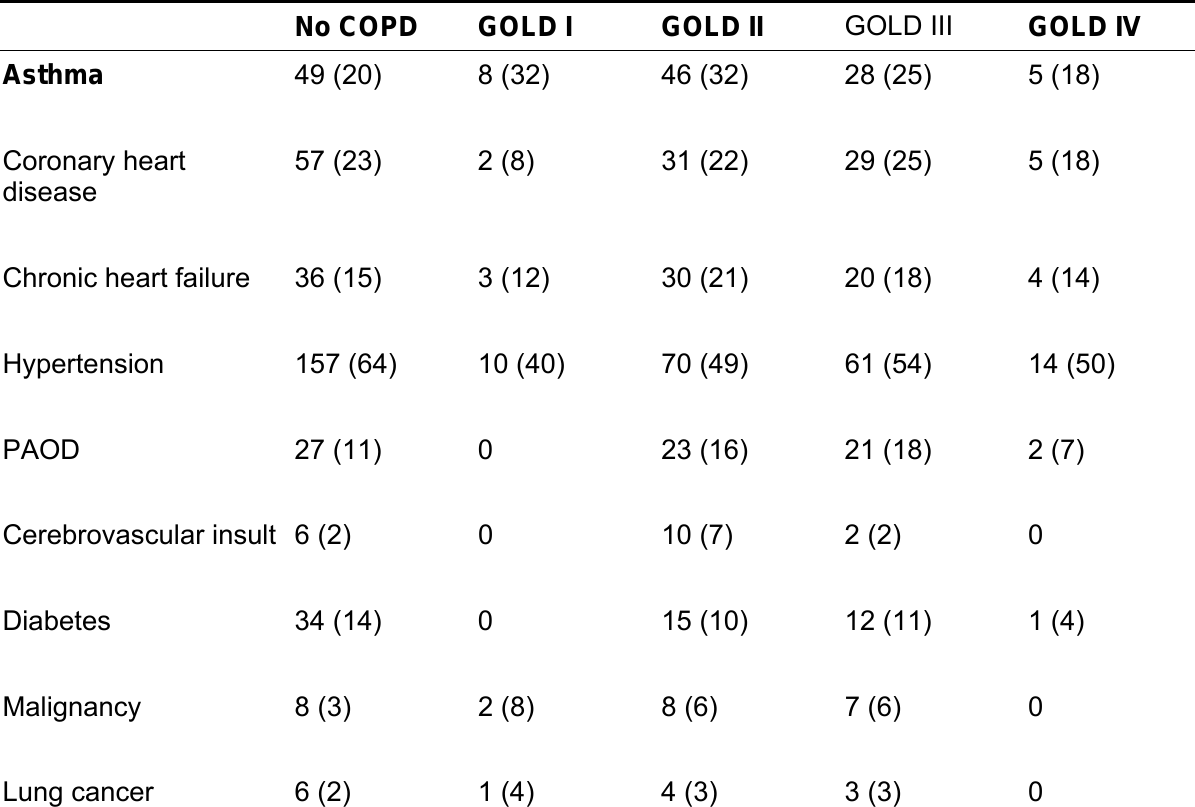
Common diagnosed condition other than